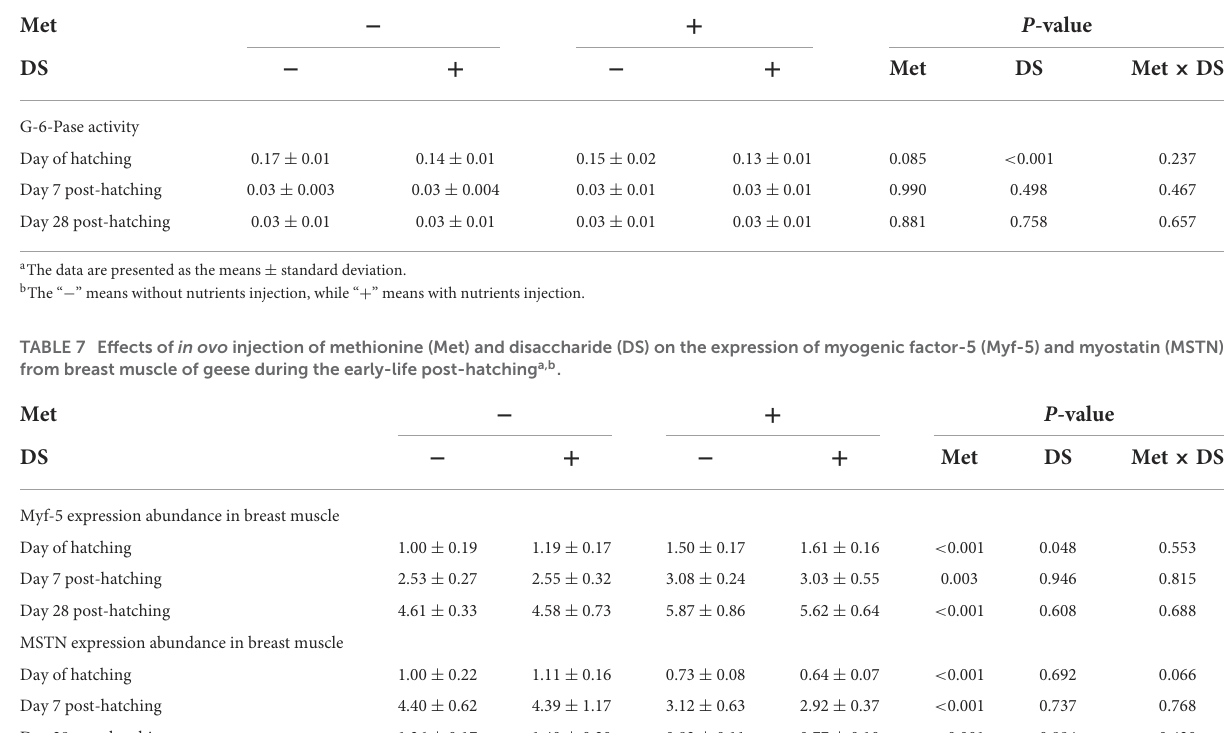
MSTN expression abundance in breast muscle